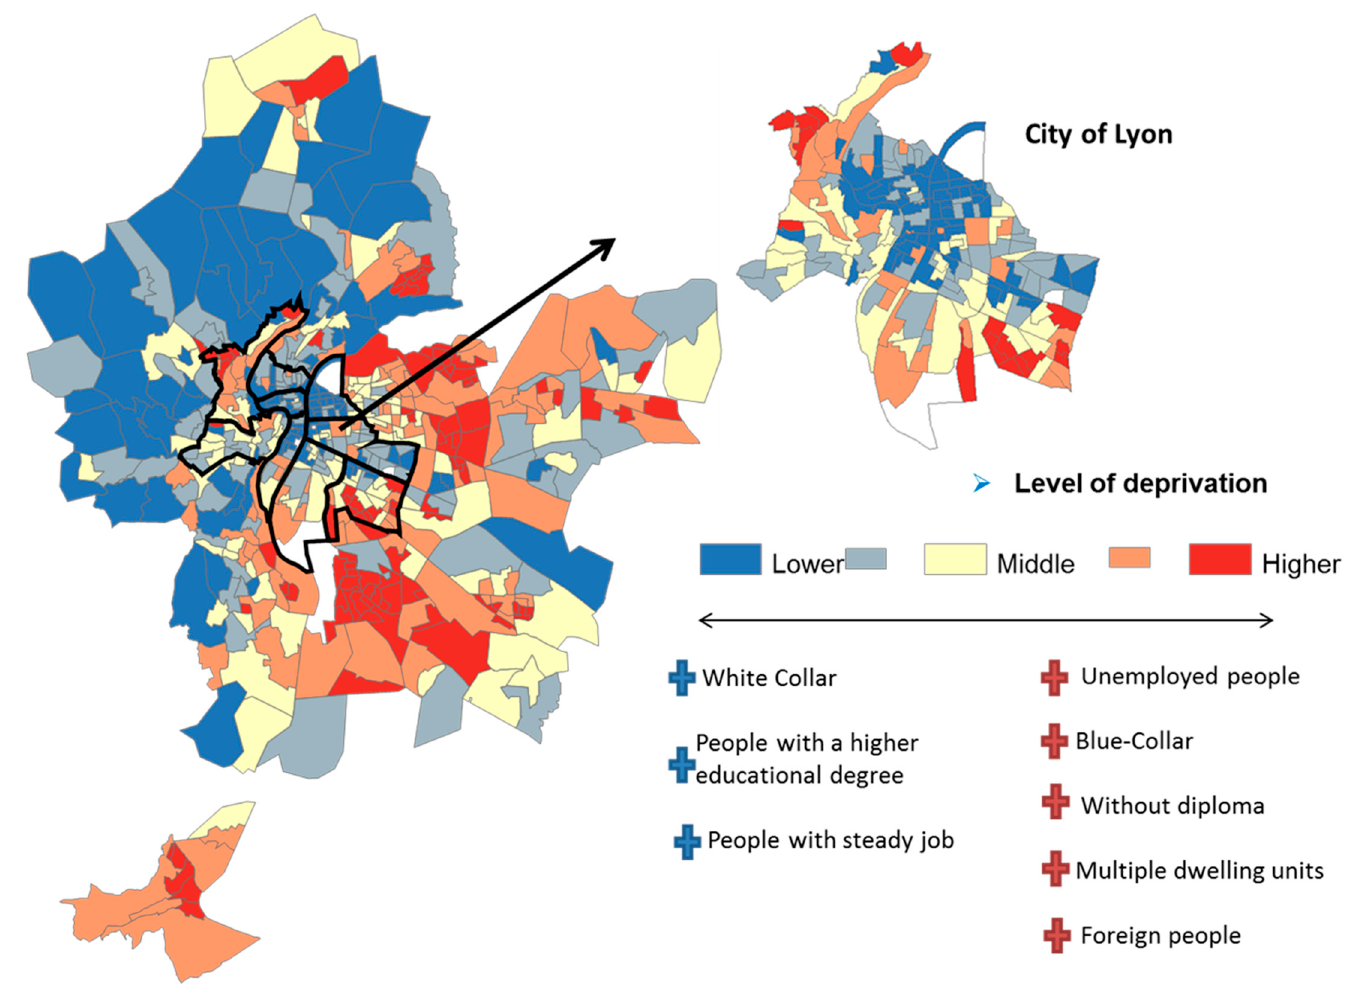
Figure 2. Spatial distribution of the deprivation index in quintiles in Lyon MA.